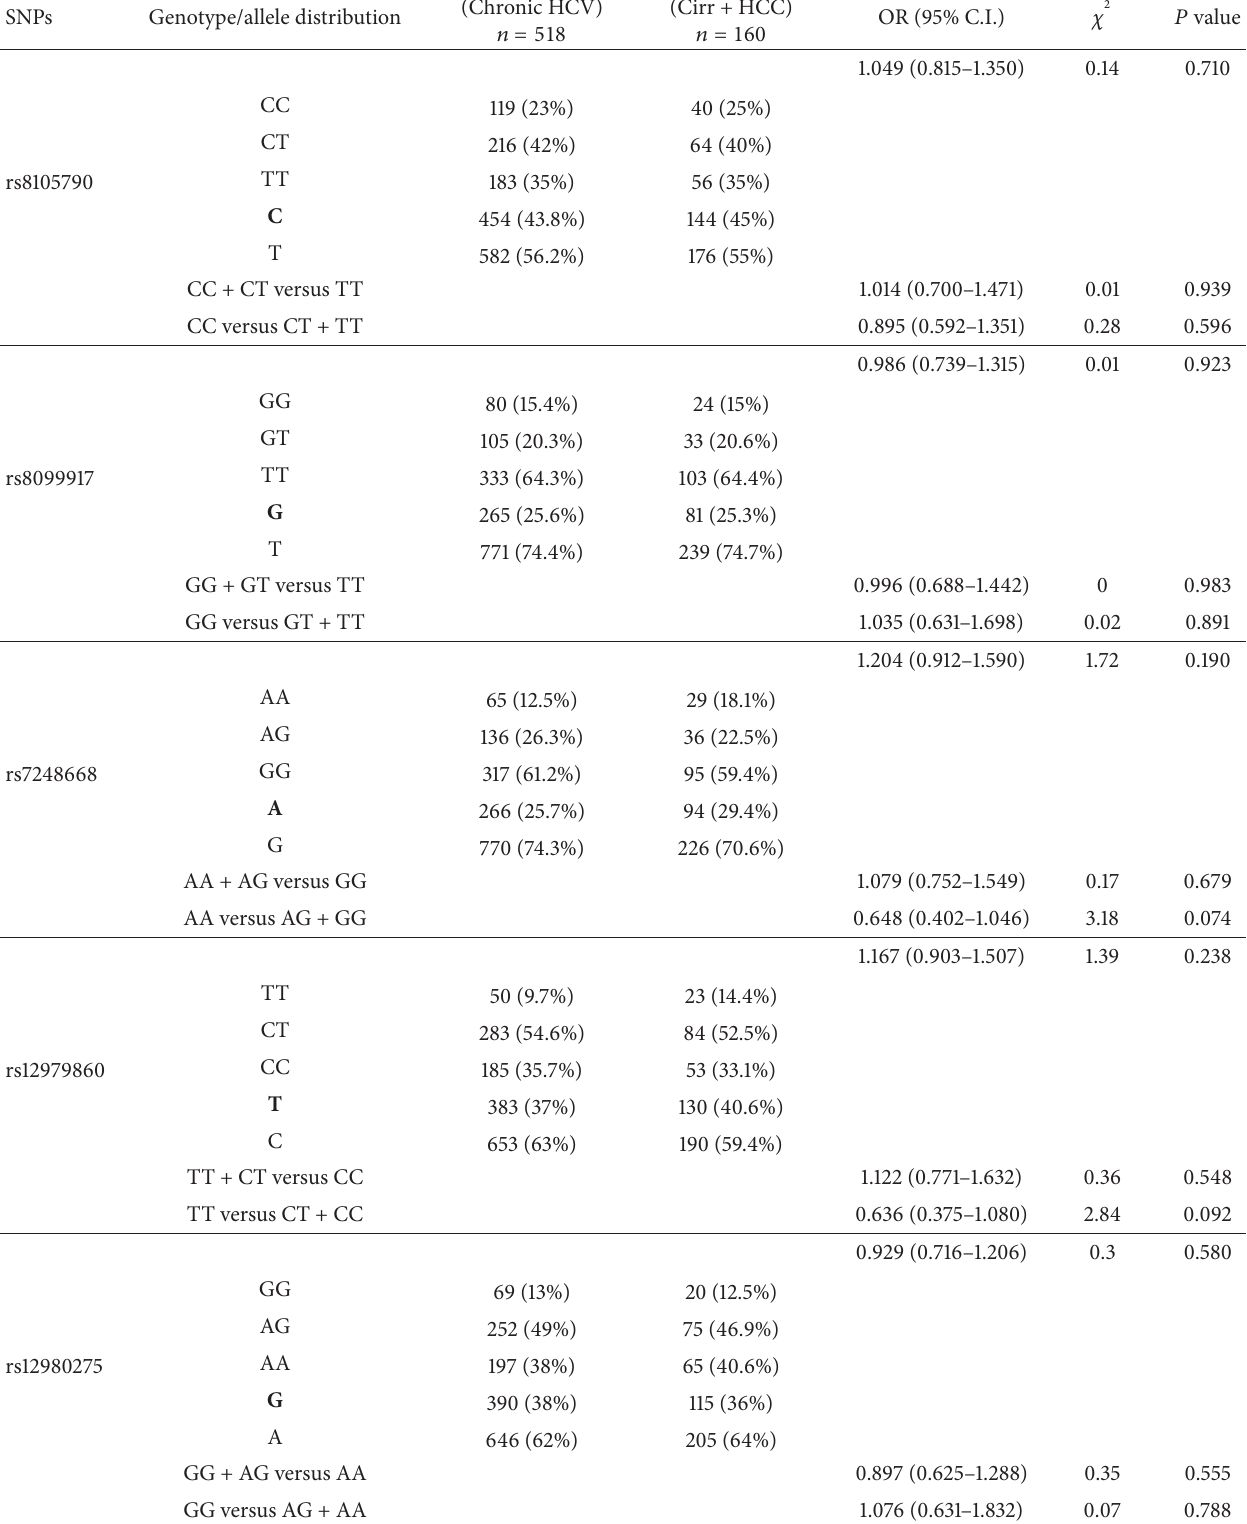
Table 4: Genotypic distribution for IL-28B gene polymorphism when chronic HCV patients (group 1) were compared to individuals with liver cirrhosis and HCC carriers (groups